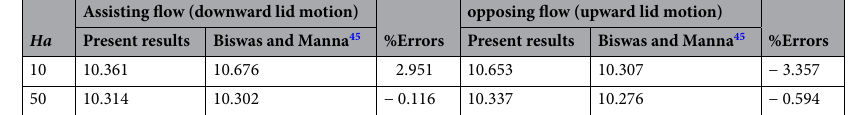
Assisting flow (downward lid motion) Ha